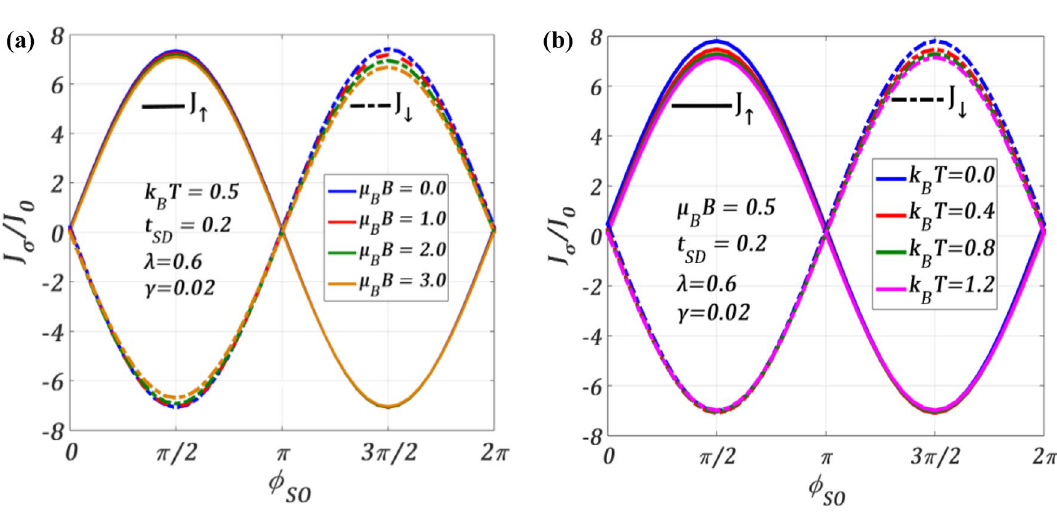
/ J 0 and ( b ) J ↑ 1.0 . =